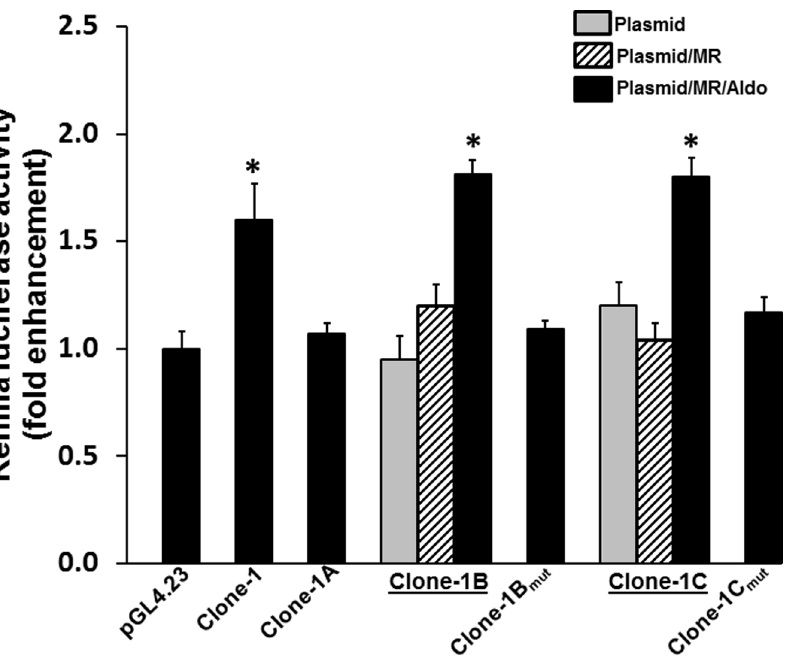
Figure 5. Sub-localization of mineralocorticoid hormone responsive element (MRE) in clone 1. Sub-clones of clone-1 were made and tested for MR/aldosterone responsiveness in HEK 293T cells. Clone-1 was sub-cloned into thirds, clone-1A, clone-1B and clone-1C representing the left, middle and right thirds, respectively. Clone-1B and clone-1C exhibited enhanced luciferase activity. Putative MREs were identified in clone-1B and clone-1C using TESS and MatInspector bioinformatics tools. The sequence TCTTGAGTGTGTTCT in clone-1B (candidate MRE underlined) was mutated to TCTTGcGTGcacgac (clone-1B mut ) (see Figure S1 for sequence). The candidate MRE GGCTCTGCGTGTTCT in clone-1C was mutated to GGCTgTGCGcacgac (clone-1C mut ). The absence of the enhanced luciferase activity in the HEK293T cells transfected with clone-1B mut and clone-1C mut showed a loss of function, thus demonstrating functionality of the MREs localized in clone-1B and clone-1C. Data presented represent mean 6 SE of triplicate assays from 3 different experiments. * p , 0.05– compared to pGL4.23.